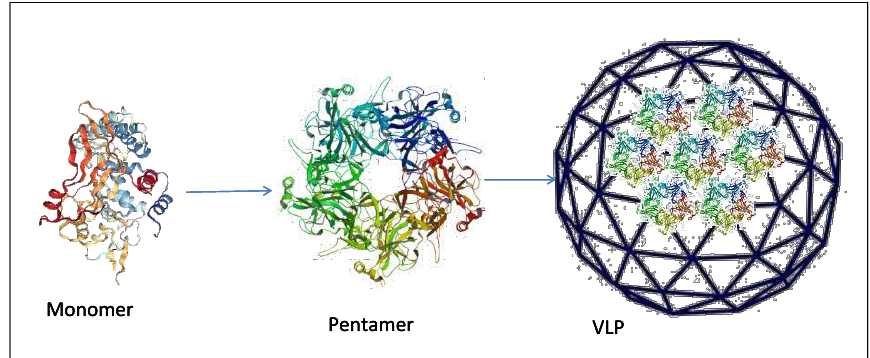
Figure 7. Schematic representation of VLPs (right). Modified from https://doi.org/10.1172/JCI85446.